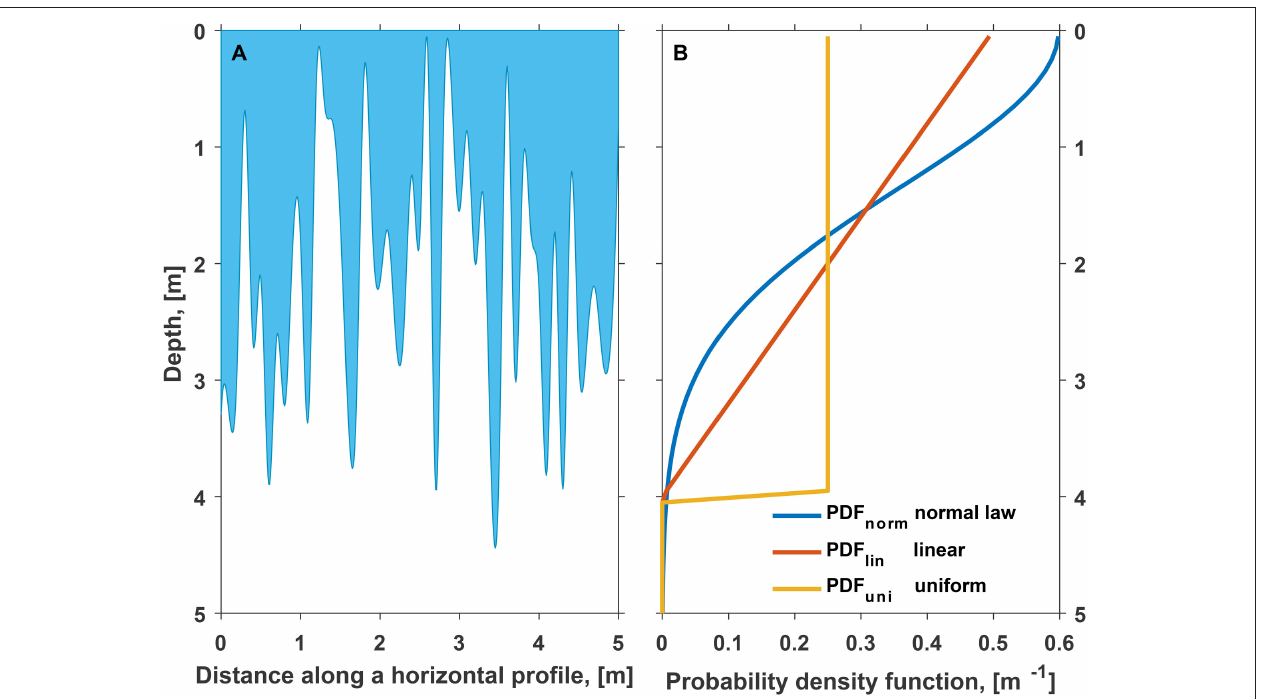
FIGURE 4 | (A) A schematic representation of preferential water flow in a snow and firn pack - blue color shows the wet part of an imaginative snow pit wall. Vertical and horizontal scales and the shape of the “wetting front” are chosen arbitrarily for illustrative purposes. (B) Probability density functions corresponding to the deep water infiltration schemes implemented in the firn model. Values along the horizontal axis can also be interpreted as the fractions of surficial water that would be allocated to a 1 m thick firn layer found at a specific